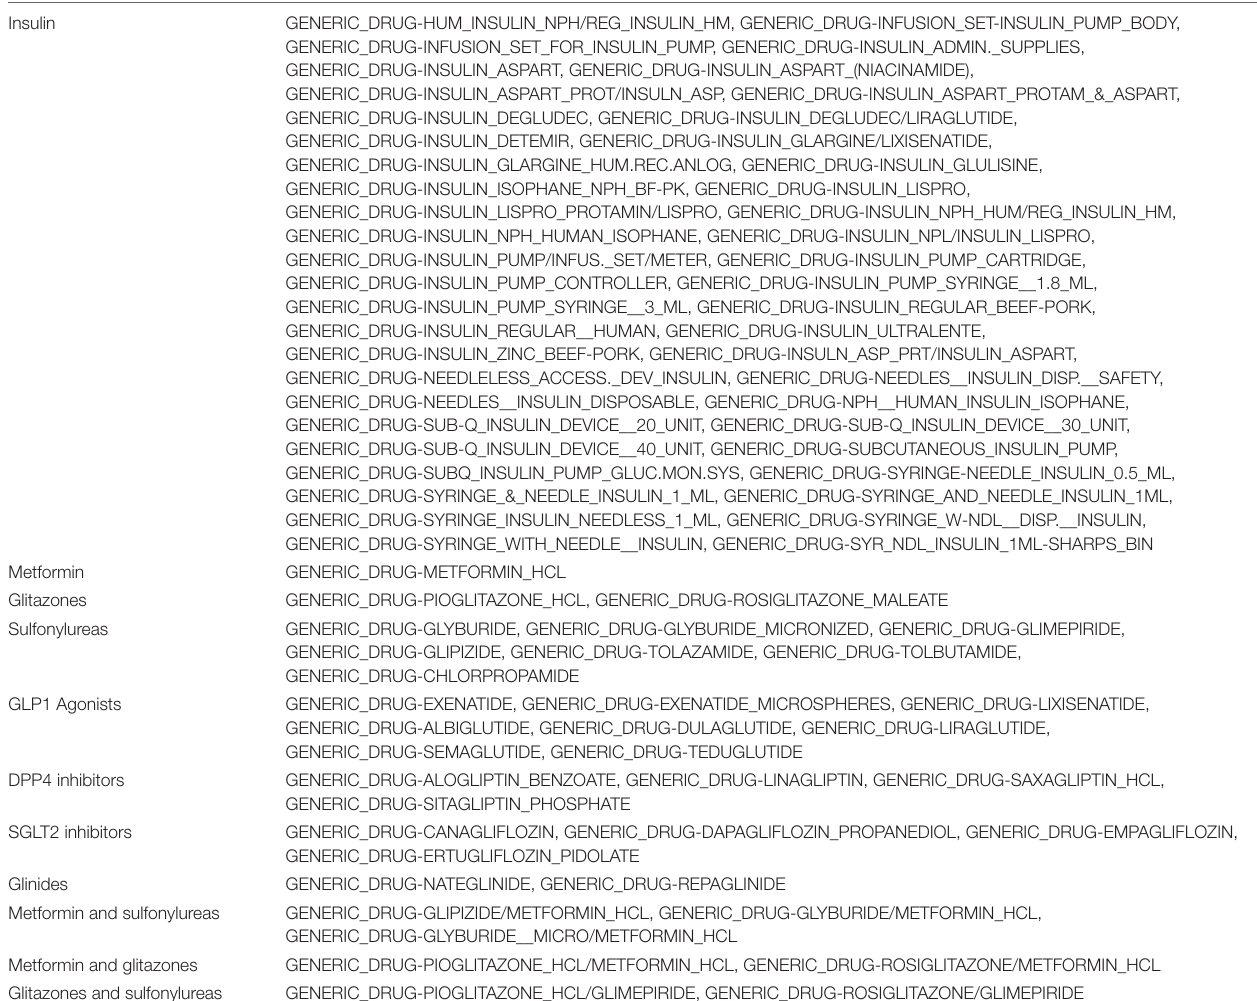
TABLE 3 | Drug codes.